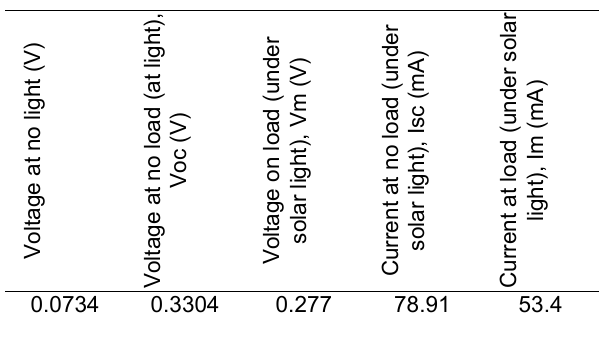
Table 8. Observations made for electrolyte sample D